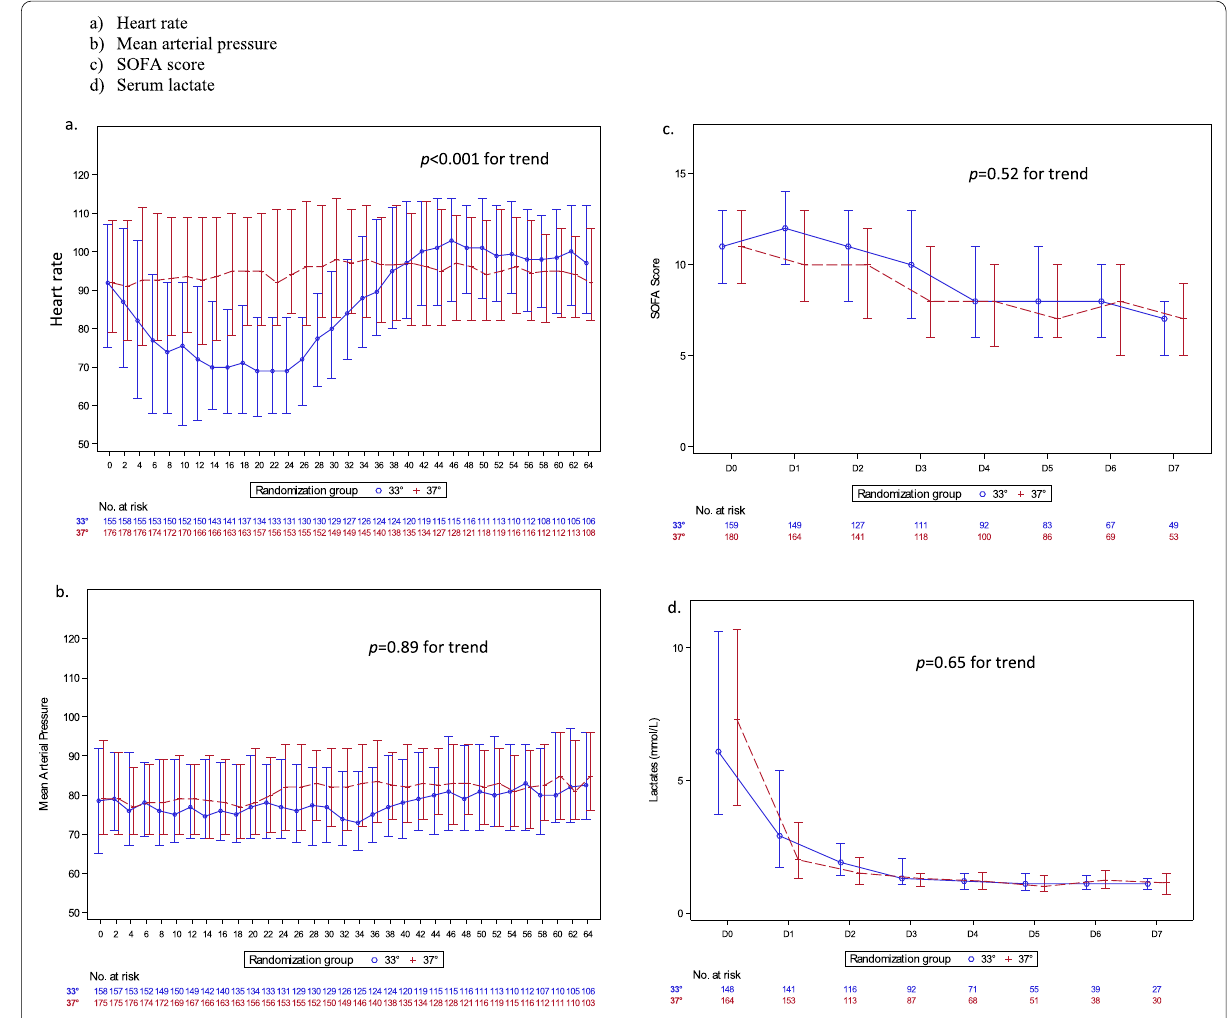
Fig. 2 Changes over time in physiological variables according to target temperature in the patients with postresuscitation shock (PRS) at admission. SOFA: Sequential Organ Failure Assessment. The lactate level was determined at admission to the intensive care